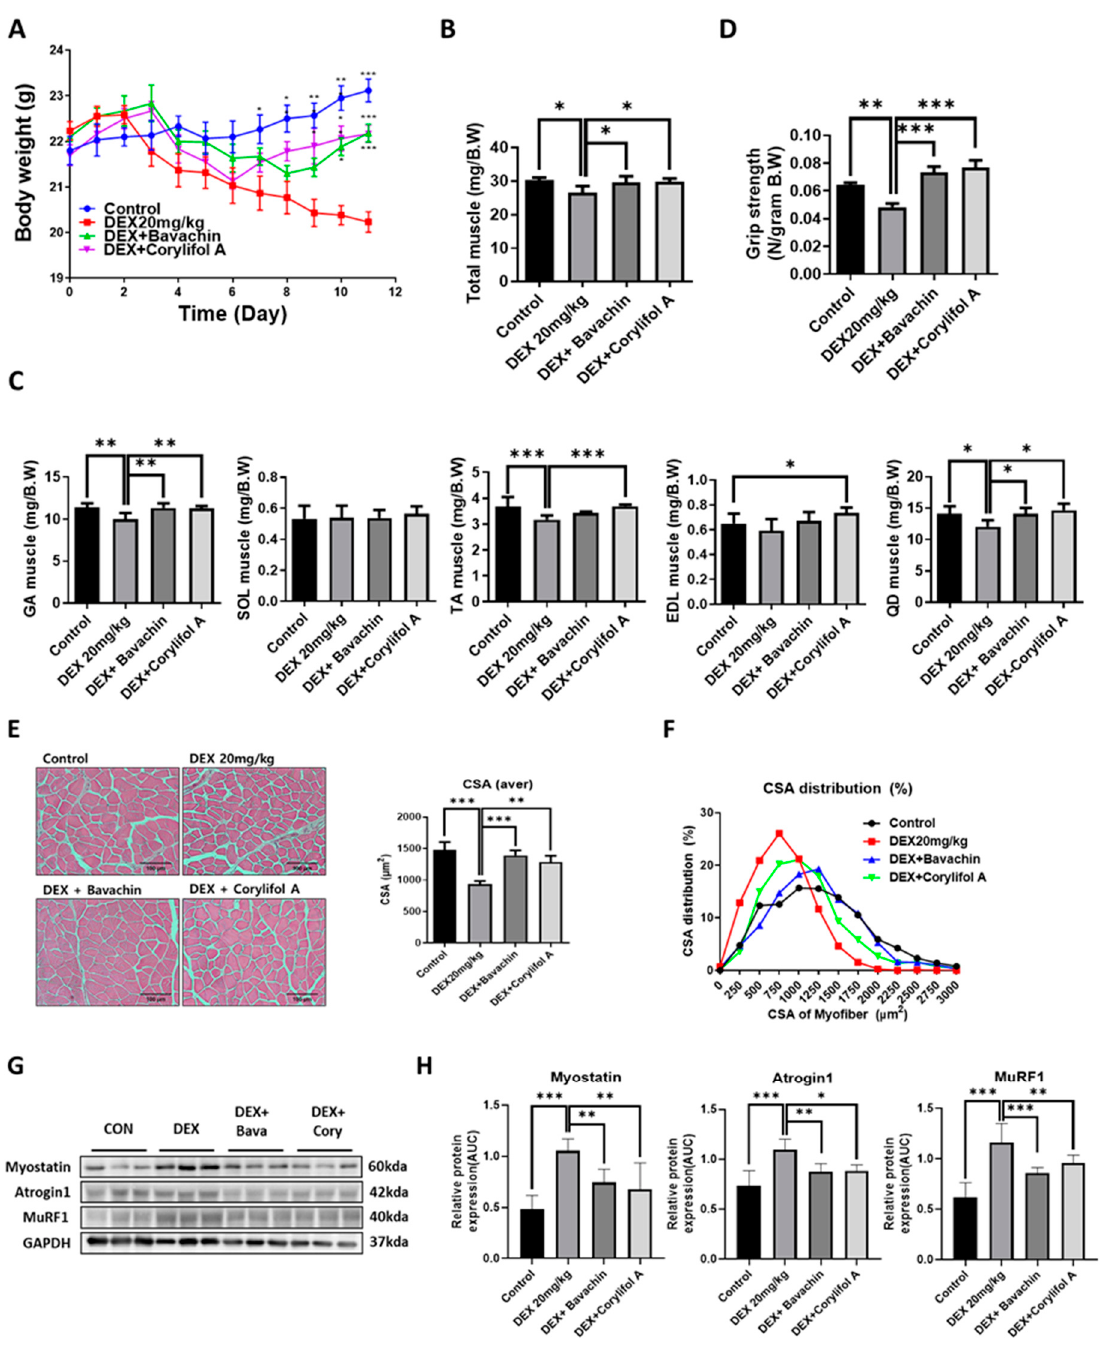
Figure 1. Bavachin (10 mg/kg) or corylifol A (10 mg/kg) was orally administered for 12 d, starting two days prior to DEX administration. ( A ) Body weight changes in mice and ( B ) total muscle weight. ( C ) Muscle weights of the gastrocnemius (GA), soleus (SOL), tibialis anterior (TA), extensor digitorum longus (EDL), and quadriceps femoris (QD) muscles. ( D ) Grip strength. ( E ) Representative images of the cross-sectional area (CSA) in the GA muscle tissue at 200× magnification. Average CSA of muscle fibers. ( F ) CSA distribution of the muscle fibers. CSA data were measured using the ImageJ software. Protein expression levels in GA muscles were determined via western blotting. ( G ) Representative images of the atrophic muscle factors. ( H ) Protein expression levels of the atrophic muscle factors. All data are represented as the mean ± standard error of the mean (S.E.M)., n = 6/group; * p < 0.05, ** p < 0.01, *** p < 0.001; nonparametric analysis of variance, followed by Kruskal-Wallis test.